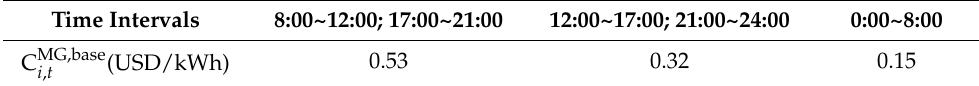
Figure 5. A modified multi-level power grid. Table 1. Power purchase price of MG.